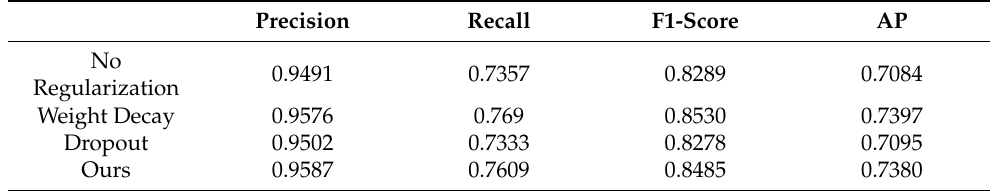
Table 4. Precision, Recall, F1-score, and AP of YOLOv3 with each regularization method. This experiment is conducted on the Utah (Validation)